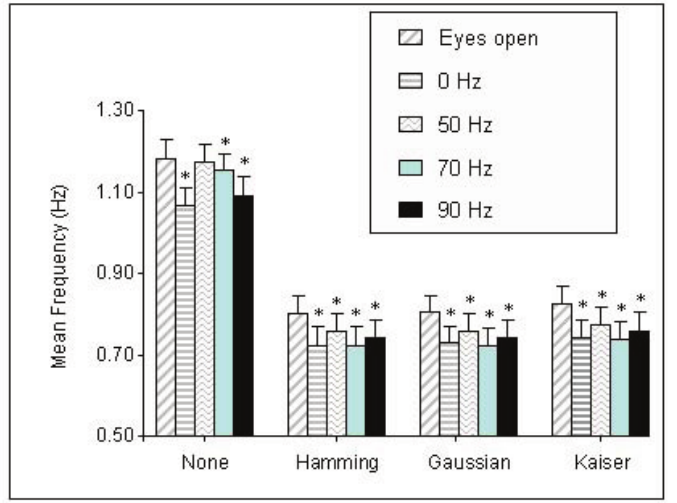
Figure 8. Mean frequency estimation using Fourier–Bessel Expansion for 200-point win- dows (AP): (a) No window; (b) Hamming window, (c) Gaussian window ( (cid:5) D 2:5 ), (d) Kaiser window ( ˇ D 8